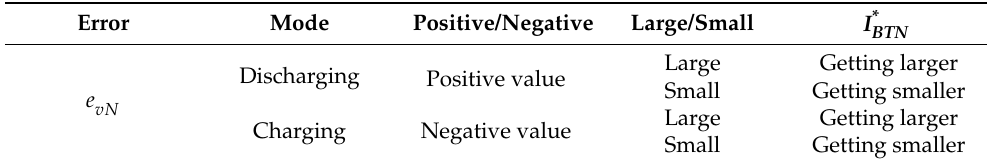
Figure 5. The control block diagram of the uniform battery pack charging/discharging. Table 2. The mapping table of uniform